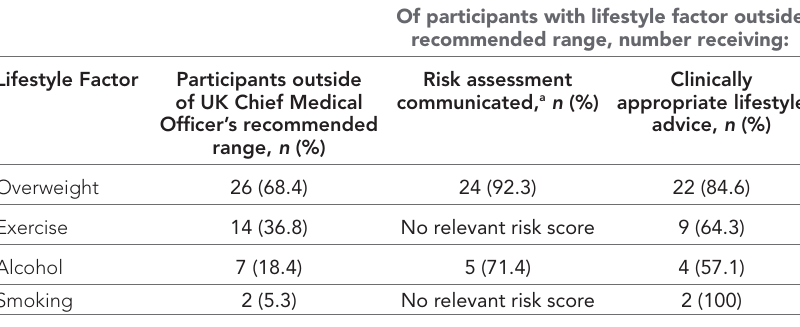
Of participants with lifestyle factor outside recommended range, number receiving: